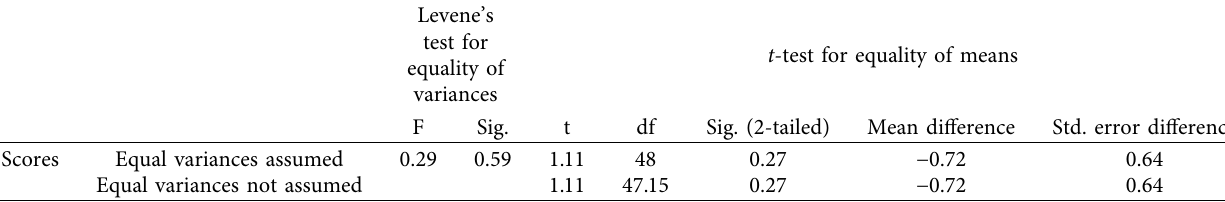
Table 2: Inferential statistics of both groups on the vocabulary pretest.